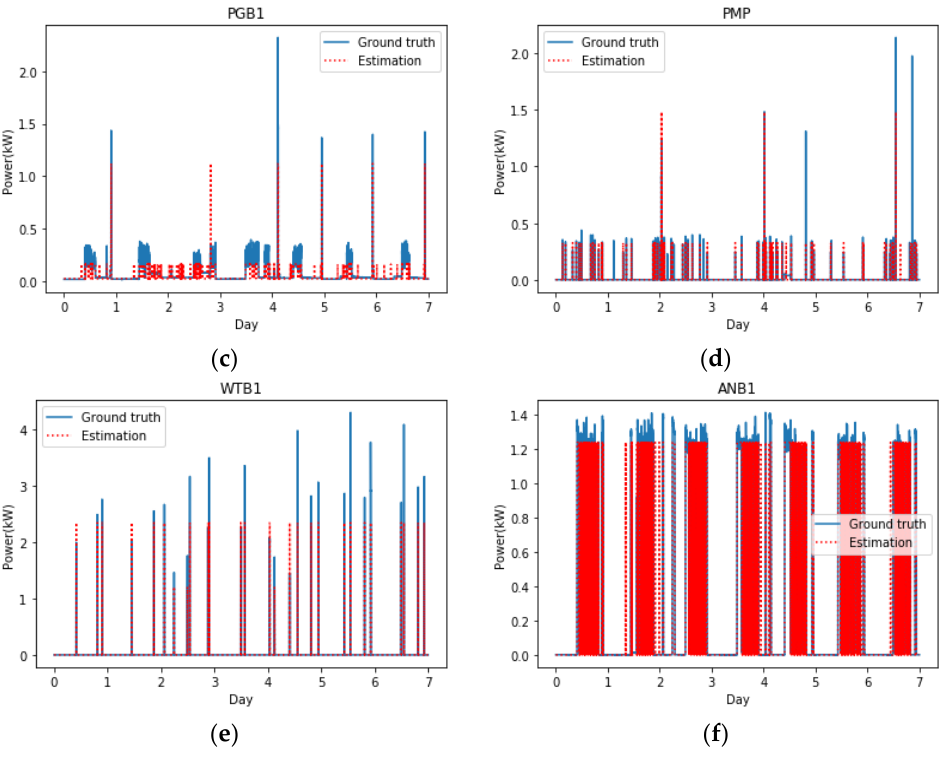
Figure 3. Power data plots of the ground truth and the estimation by the MTC model ( a ) LTL; ( b ) LTB1; ( c ) PGB1; ( d ) PMP; ( e ) WTB1; and ( f ) ANB1.